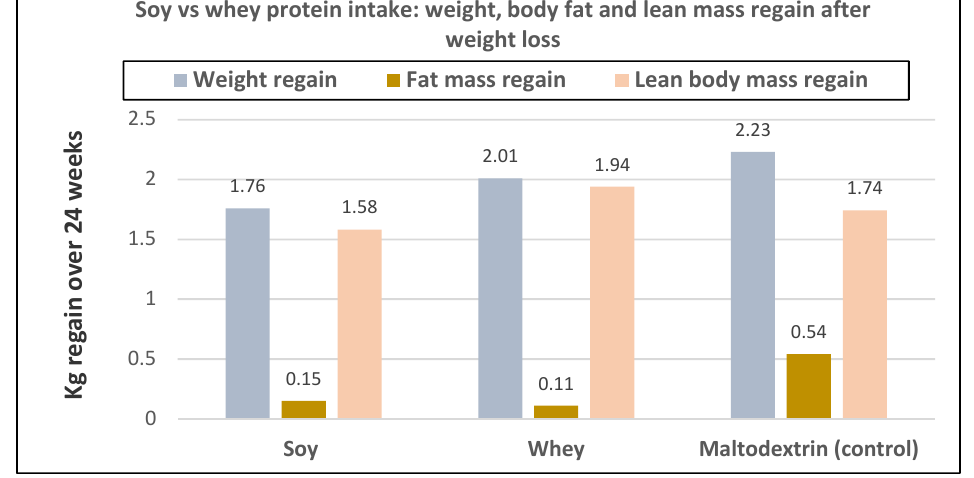
Figure 21. Change in anthropometric measures in 60 women with polycystic ovary syndrome (mean age 25 years and BMI 28) consuming isocaloric diets with 0.8 g protein per kg from soy group (35% soy protein, 35% animal protein and 30% plant protein) vs. non-soy control (70% animal protein and 30% vegetable protein) for eight weeks [61].